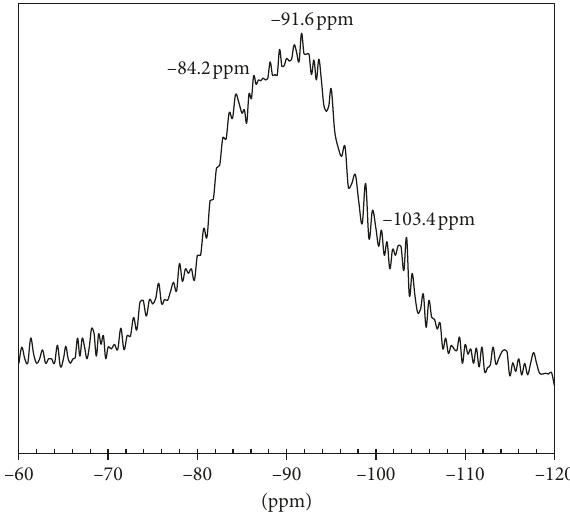
Figure 8: 29 Si MAS-NMR spectrum of the geopolymer specimen produced at 75%